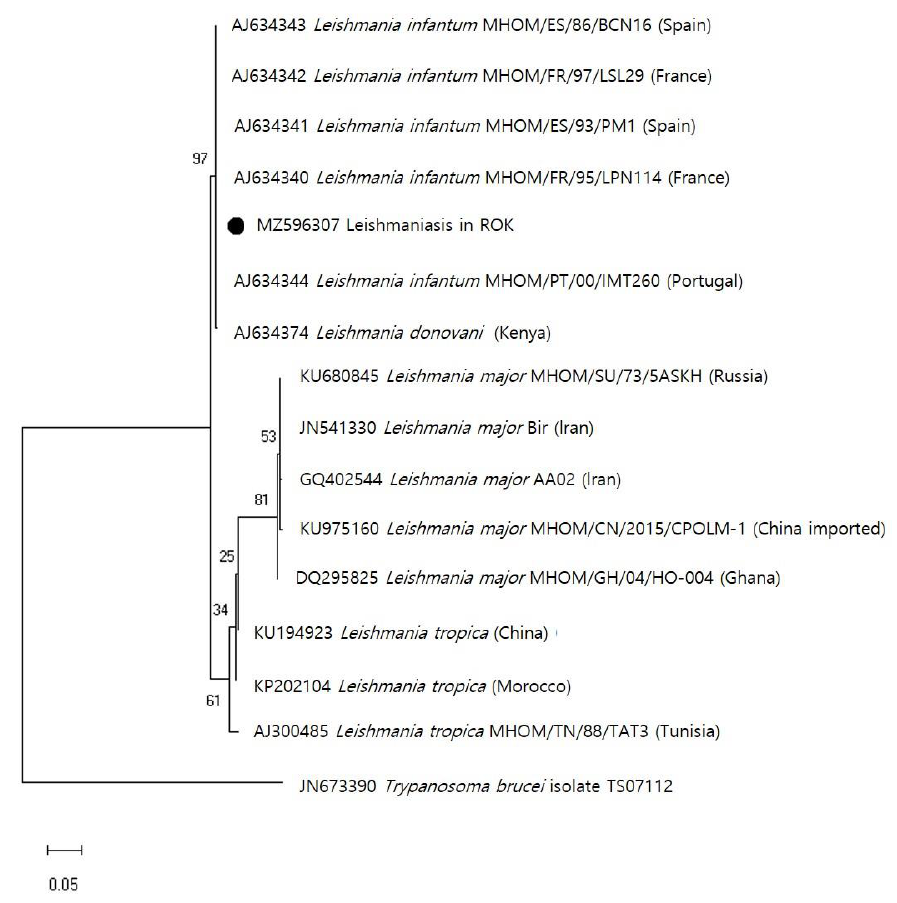
Figure 2. Maximum-likelihood phylogenetic tree of internal transcribed spacer 1 and 5.8 S ribosomal RNA sequences of Leishmania . The Leishmania infantum sequence identified in this study is indicated by a solid circle ( • , GenBank accession no. MZ596307). The scale bar indicates 0.05 nucleotide substitutions per site.